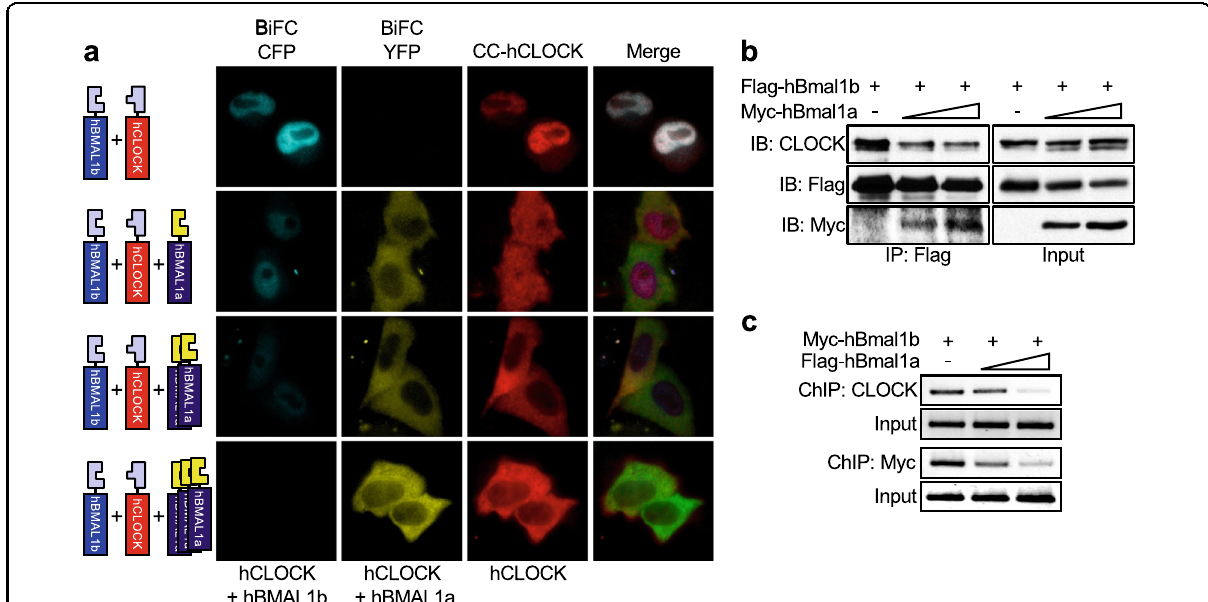
Fig. 4 The effect of hBMAL1a on the formation of the hBMAL1b and hCLOCK heterodimer complex. a CN-hBmal1b and CC-hClock were co- transfected with increasing amounts of YN-hBmal1a to visualize the effect of hBMAL1a on the heterodimerization of hCLOCK and hBMAL1b. Twenty- four hours after transfection, the signals for hCLOCK:hBMAL1b complex (CFP) or hCLOCK:hBMAL1a complex (YFP) were detected under a fl uorescence microscope. The subcellular localization of CC-hCLOCK was also detected by immuno fl uorescence staining using an anti-CLOCK antibody. b The effect of hBMAL1a on the formation of the hCLOCK:hBMAL1b complex was further investigated by an immunoprecipitation assay. c The effect of hBMAL1a on the recruitment of either hBMAL1b or hCLOCK to the E-box element of the hPer1 promoter was analyzed by chromatin immunoprecipitation (ChIP)